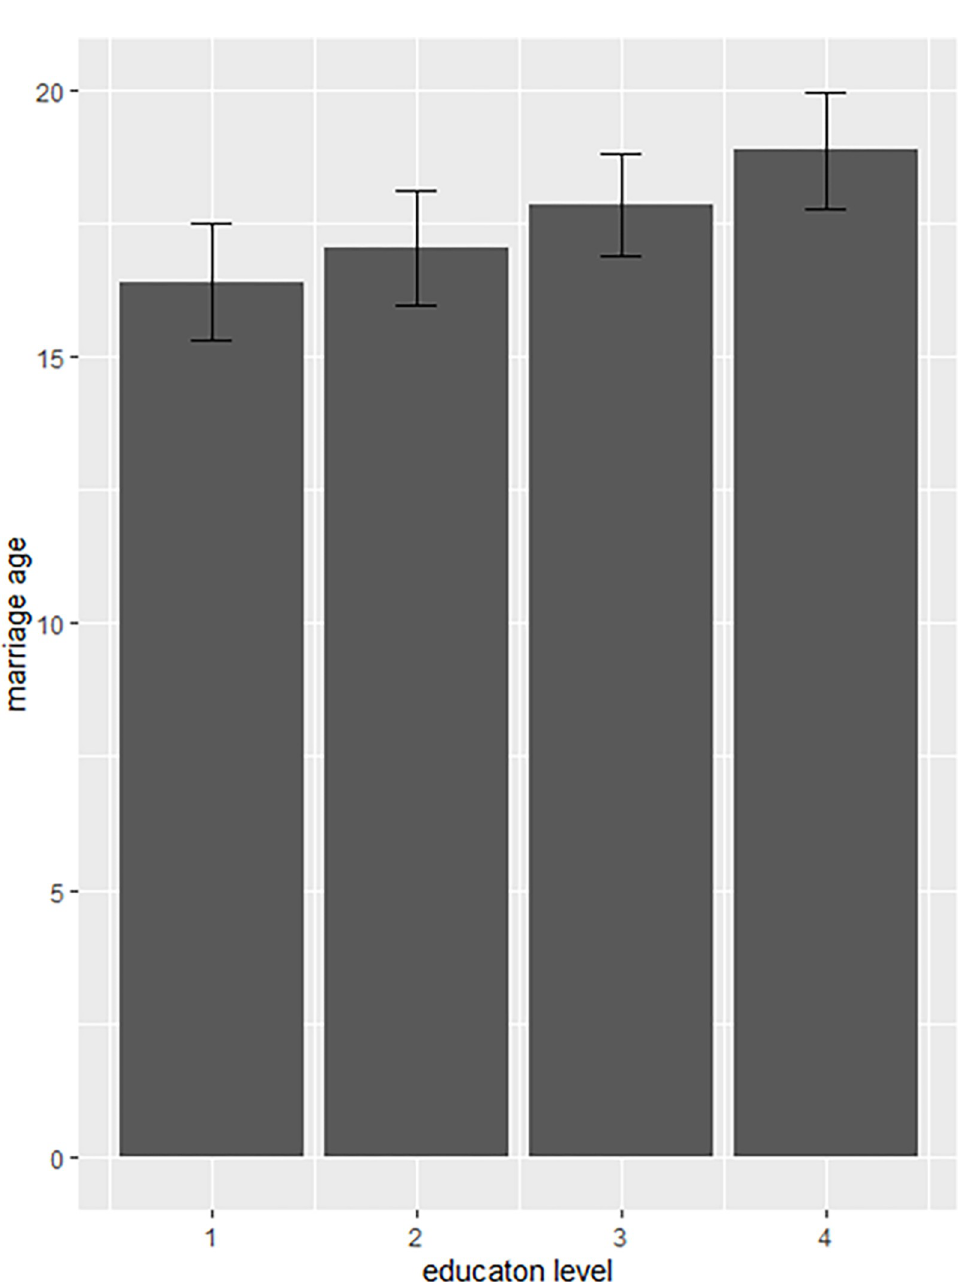
Fig 3. Average age at marriage by education level. The upper and lower hinges represent the upper/ lower limits of 95% CI. 1–4 represent women’s level of education: 1– illiterate, 2 –primary (1st–5th standards), 3 –middle school (6th–8th standards), 4 –high school (9th–10th standards), and higher secondary (11th–12th